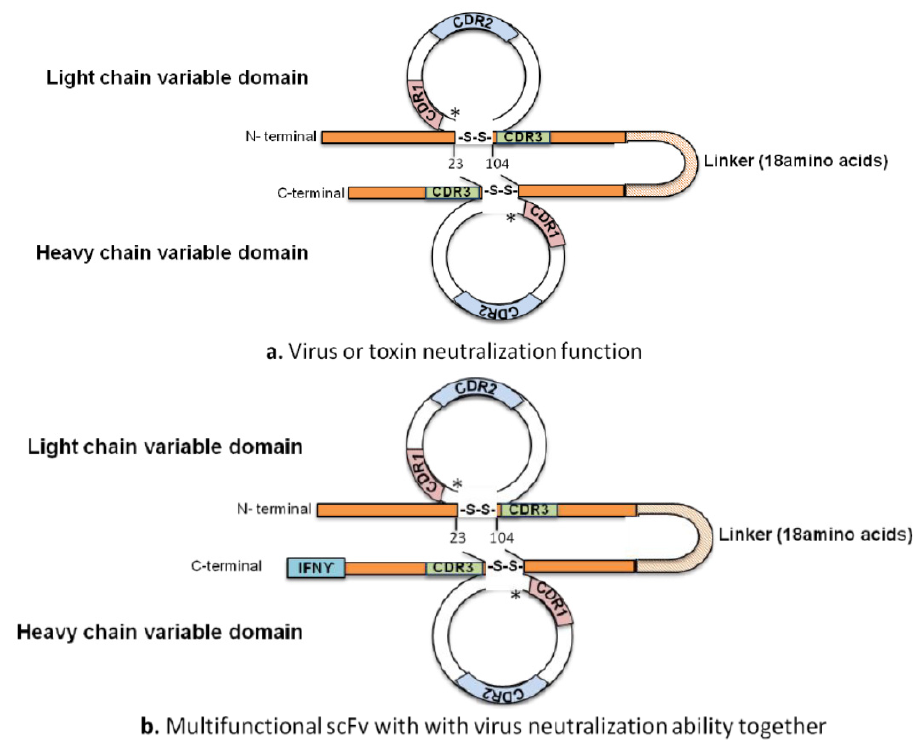
Figure 1. Diagrammatic representation of antibody fragment, scFv, design for virus or toxin neutralization function ( a ); expression as fusion protein with cytokine, e.g., interferon- ϒ for multiple combined functions, such as, virus neutralization, innate and cell mediated immunity against a virus ( b ); and epitope or cytokine grafting in the CDR3H of bovine scFv to achieve antigenization or immunomodulation function ( c ). * Indicates three FR amino acids before VH